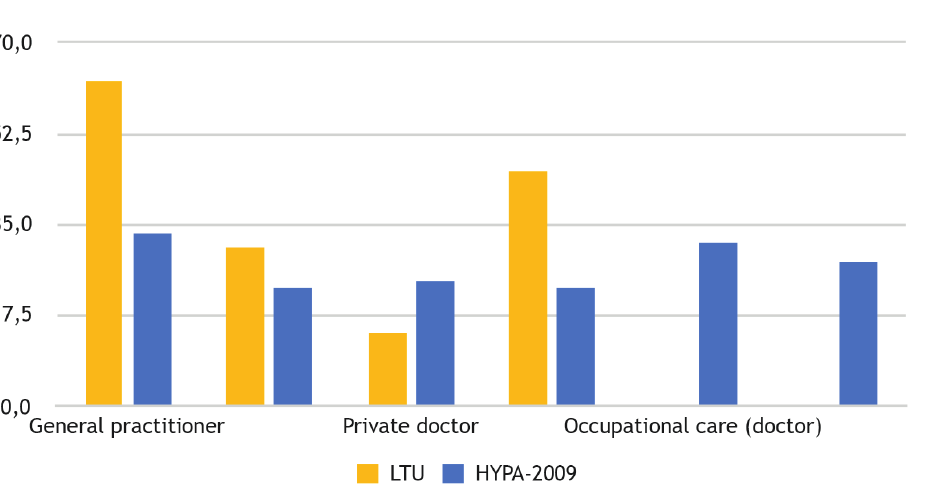
Figure 1. Percentage of individuals with outpatient health services use in last 12 months (LTU = long-term unem- ployed; HYPA-2009 = general population in employment).